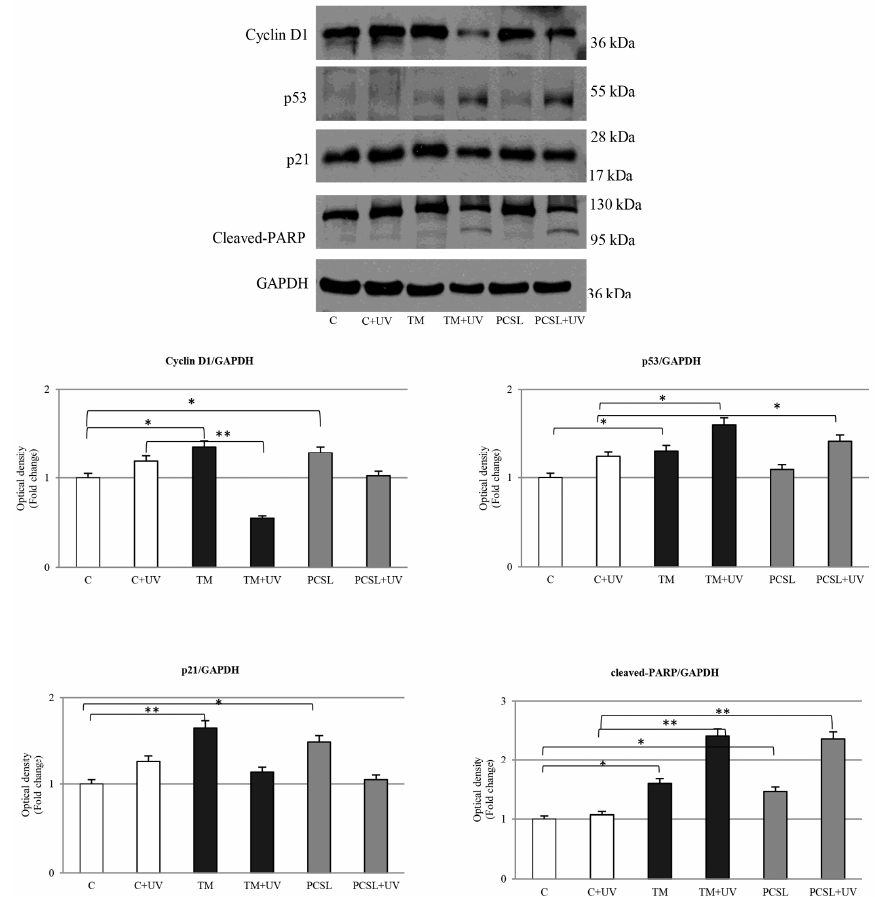
Figure 7. Western blot analysis of Cyclin D1, p53, p21, and PARP (poly ADP-ribose polymerase) protein levels in C32 cells treated or not with TM and PCSL extracts for 24 h, both in the presence and absence of UV. The histograms represent the mean ± SD of three separate experiments in which band intensities were evaluated as optical density (OD) and expressed as fold change relative to control; * p ≤ 0.05; ** p ≤ 0.005 vs. control (C) and control + UV (C+UV).